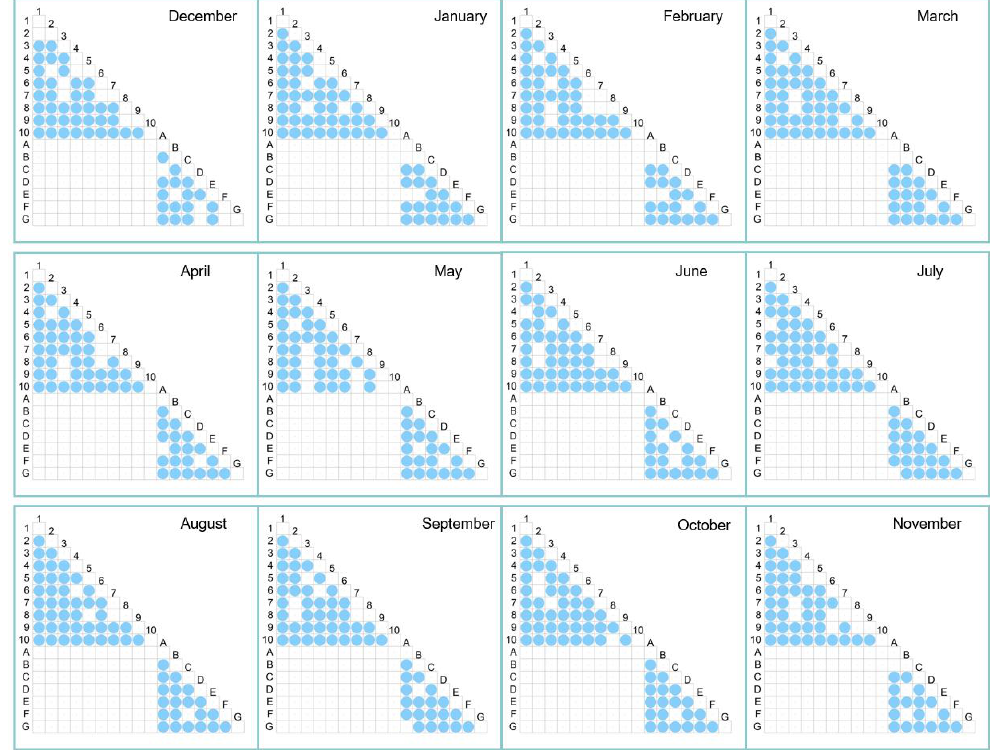
Figure 7. Difference of land surface temperatures of local climate zone types within the whole study area (Circle denotes significant difference at p < 0.05 level, blank demotes no significant difference).